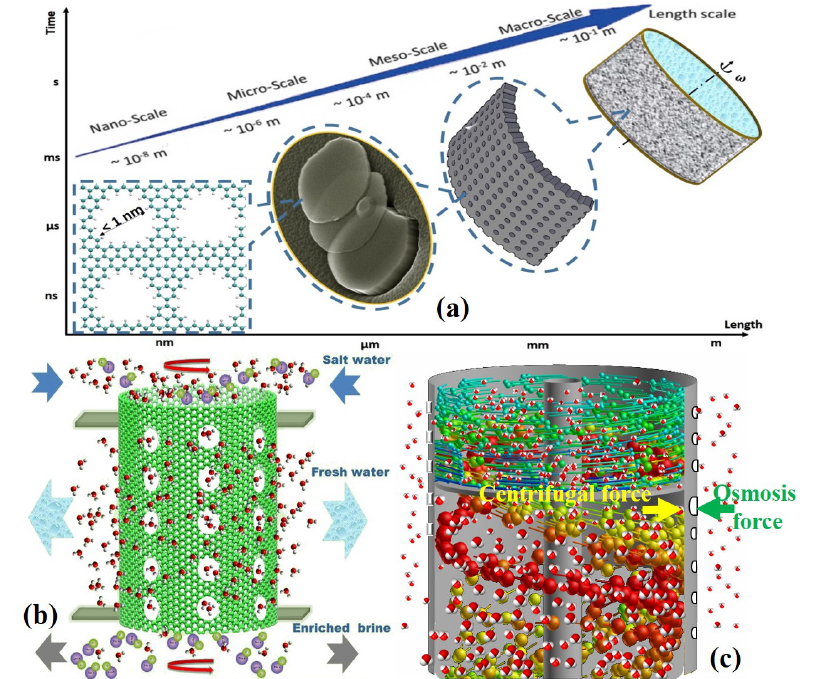
Figure A1. Schematic illustration on how to scale-up a nano-porous rotating membrane to macroscale and its macroscale fabrication concept. ( a ) Multiscale porous membrane structure, ( b ) Rotating porous membrane, and ( c ) A rotator-generated centrifugal fluid motion of the feed solution (seawater in